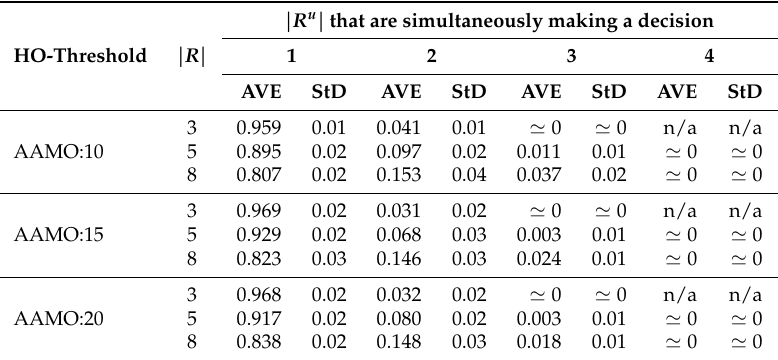
Table 6. AAMO Robot Coincidence on Decision Making